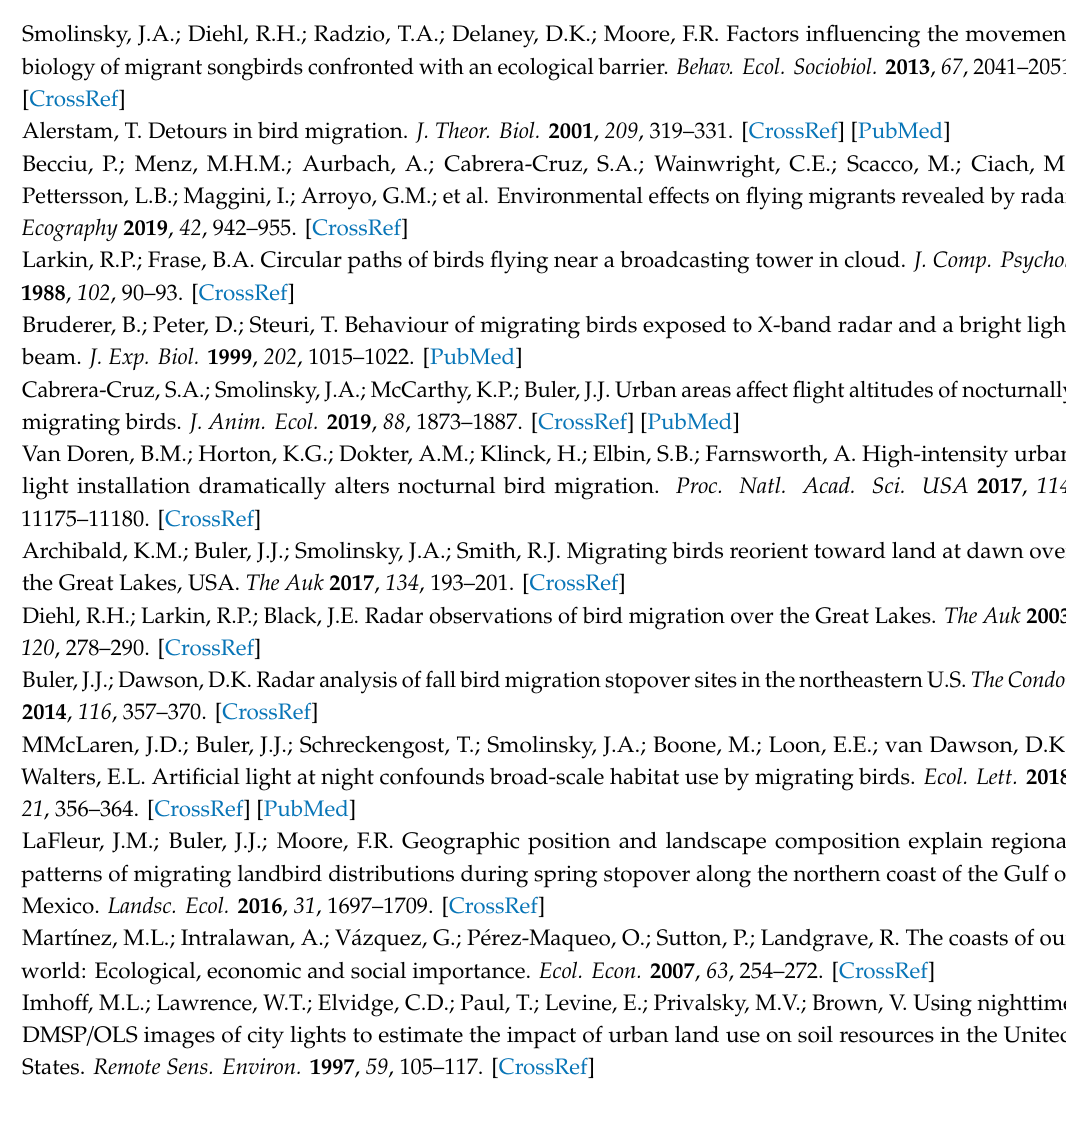
fall; Figure S8: Partial dependency plot for the most important interaction between predictors of bird densities around the Cancun radar in spring. Video S1: Animation of scans from the Cancun radar showing the evolution of reflectivity measures with the typical appearance of bird migration